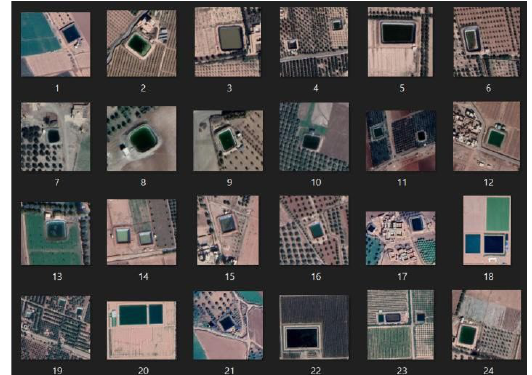
Figure 1. A section of images dataset used to train the deep learning model.